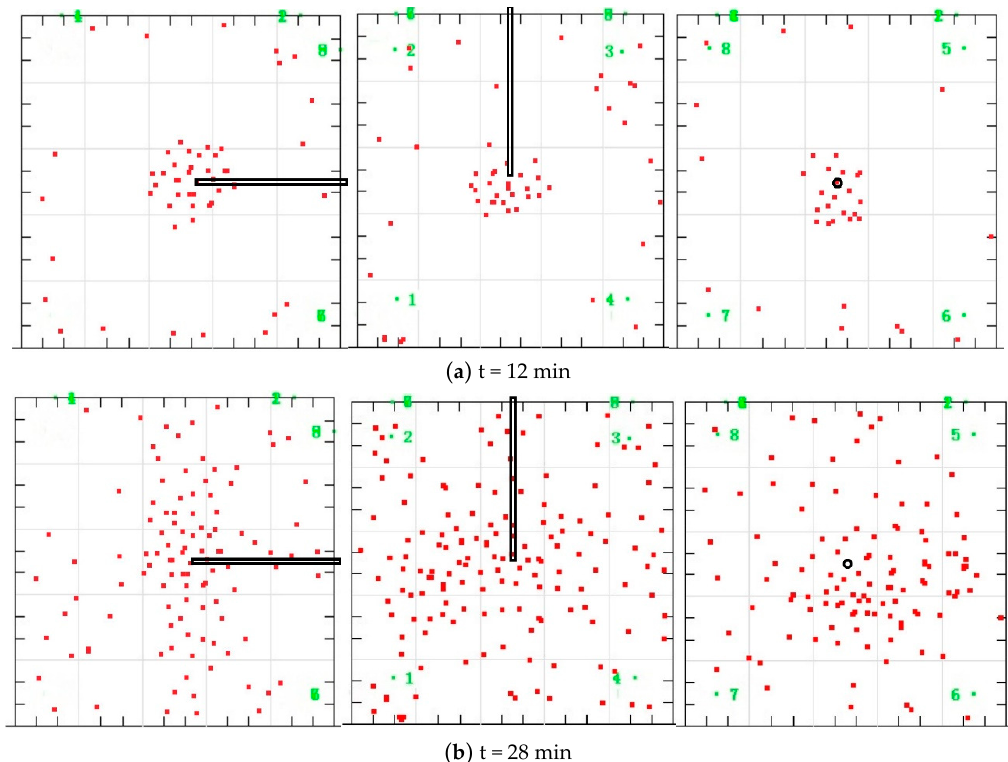
Figure 13. AE results of the fracturing of F1 at t = 12 min ( a ) and t = 28 min ( b ).